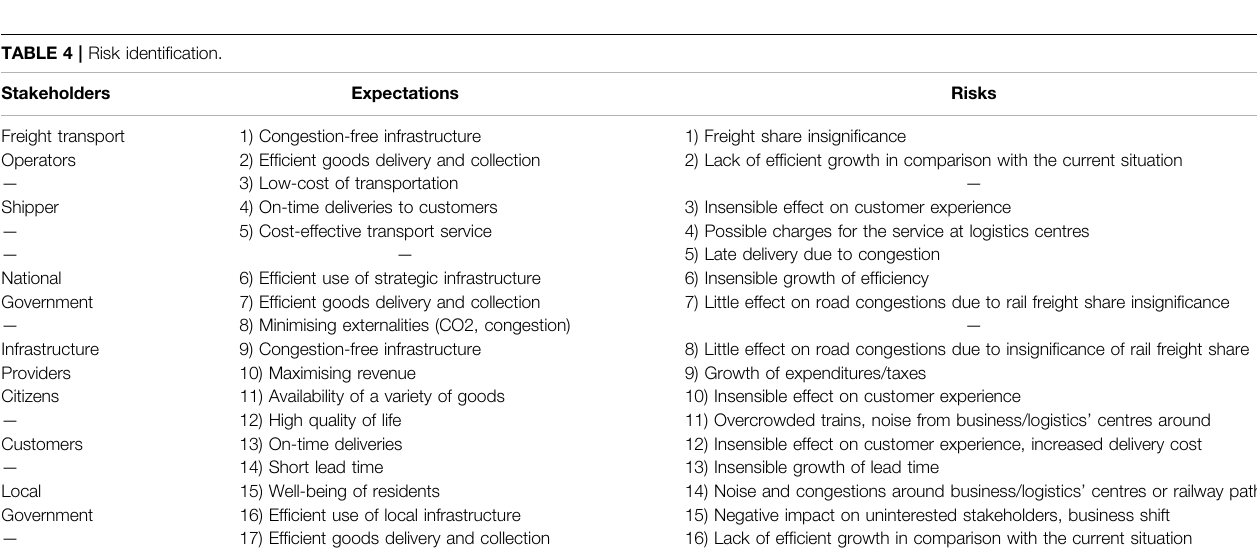
TABLE 4 | Risk identi fi